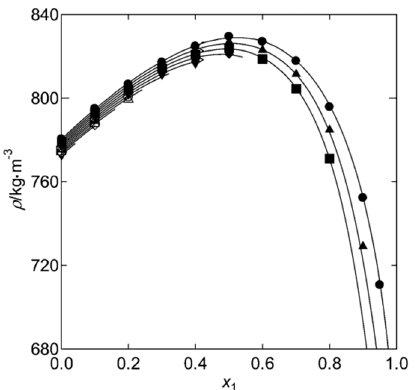
Figure 12. Densities of CO 2 + ethanol mixture with respect to mole fraction of CO 2 at 313.15 K: ● , 10 MPa; ▲ , 9 MPa; ■ , 8 MPa; ♦ , 7 MPa; ▼ , 6 MPa; ○ , 5 MPa; Δ , 4 MPa; □ , 3 MPa; ◊ , 2 MPa; ▽ , 1 MPa. Adapted with permission from [81]. Copyright 2017 American Chemical Society.